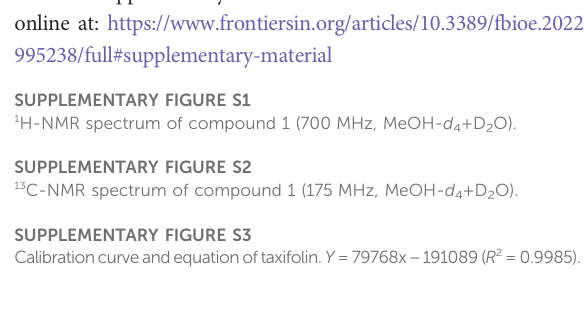
SUPPLEMENTARY FIGURE S1 1 H-NMR spectrum of compound 1 (700 MHz, MeOH- d 4 +D 2 O). SUPPLEMENTARY FIGURE S2 13 C-NMR spectrum of compound 1 (175 MHz, MeOH- d 4 +D 2 O). SUPPLEMENTARY FIGURE S3 Calibrationcurveandequationoftaxifolin. Y =79768x − 191089( R 2